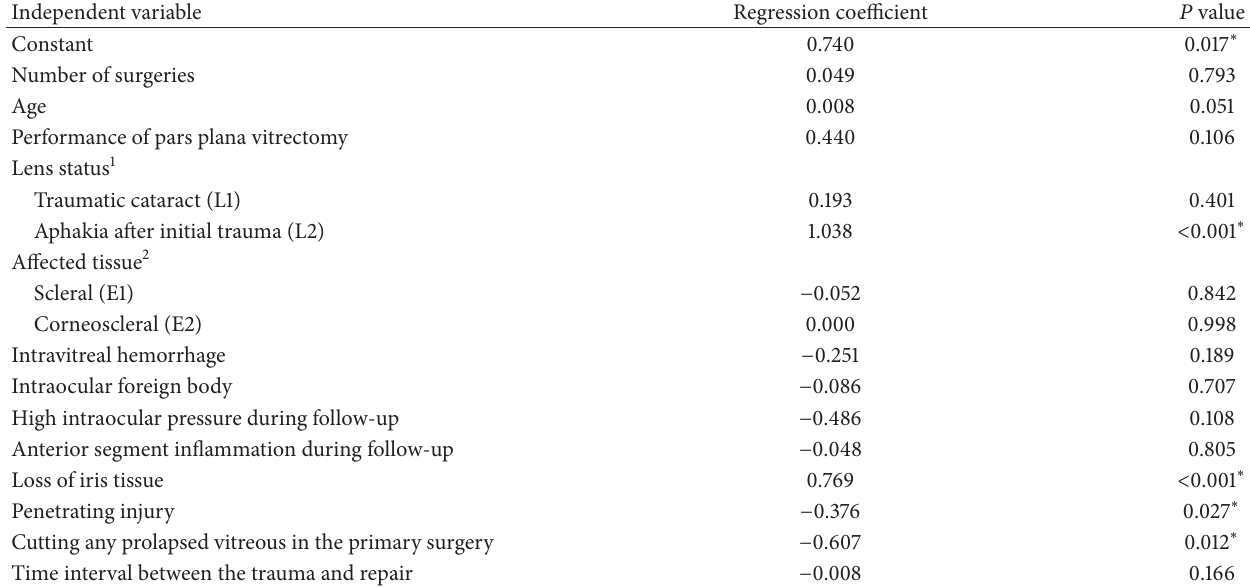
Table 3: The influences of thirteen independent variables on the final visual outcome using the multiple linear regression analysis.